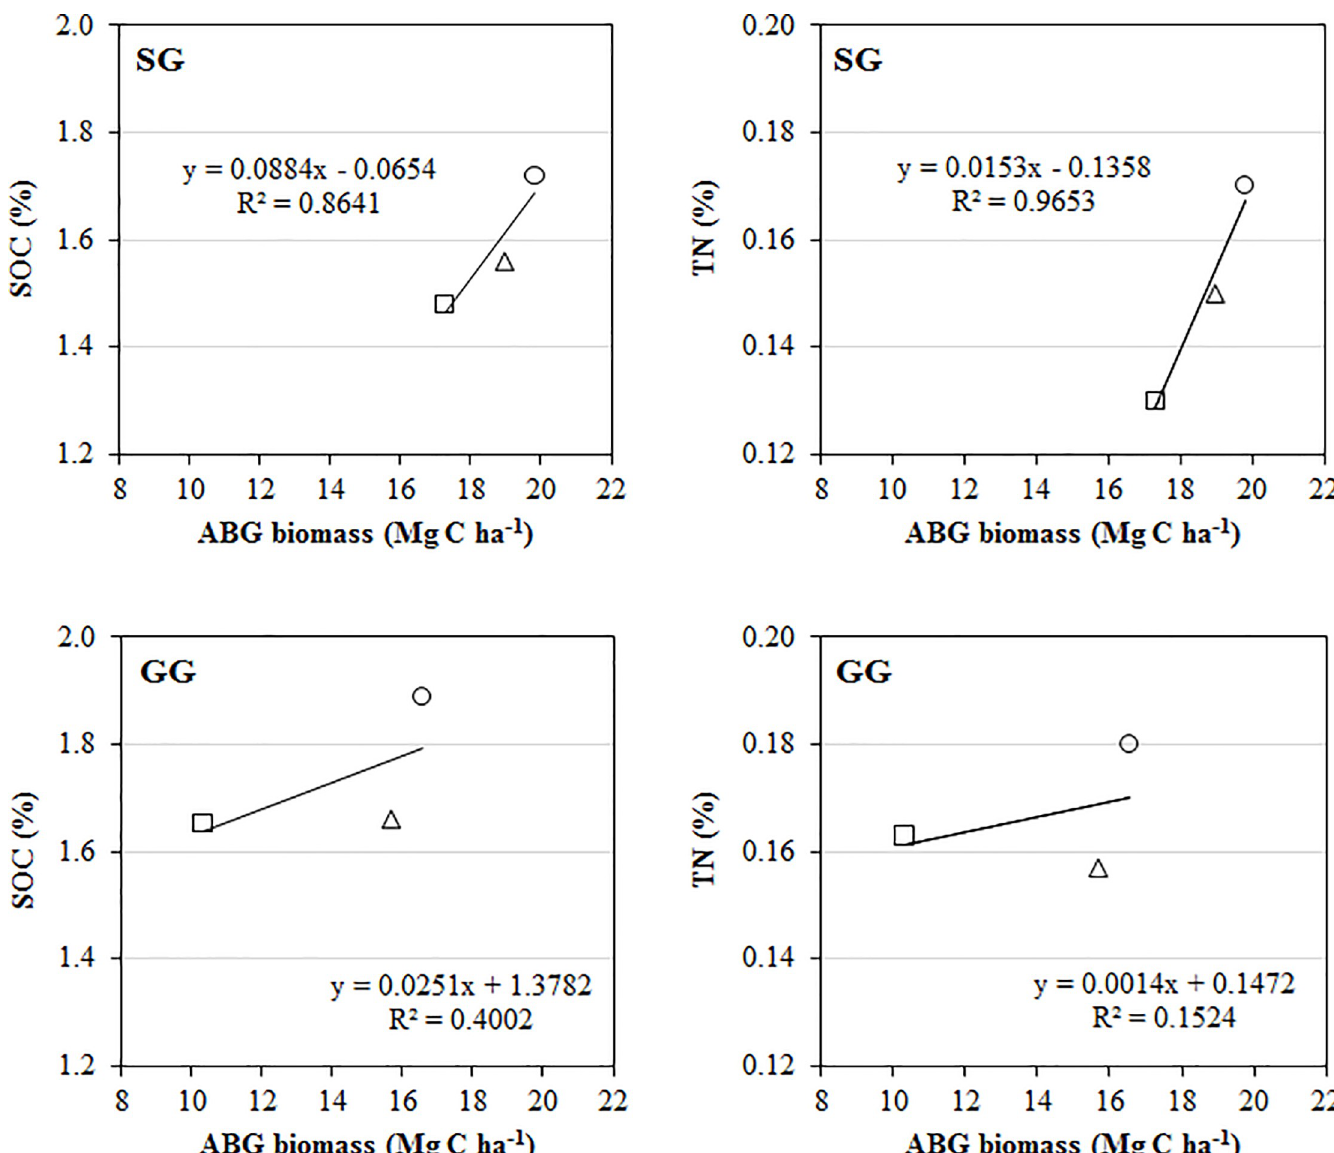
Fig 2. Regression plots of mean SOC, TN and plant ABG biomass under NN ( □ square), LN ( Δ triangle) and HN ( � circle) in SG and GG croplands. Plant ABG biomass was referred to the collection in 2015 only. NN: no N input; LN: low N input (84 kg N ha -1 in urea); HN: high N input (168 kg N ha -1 in urea); ABG: